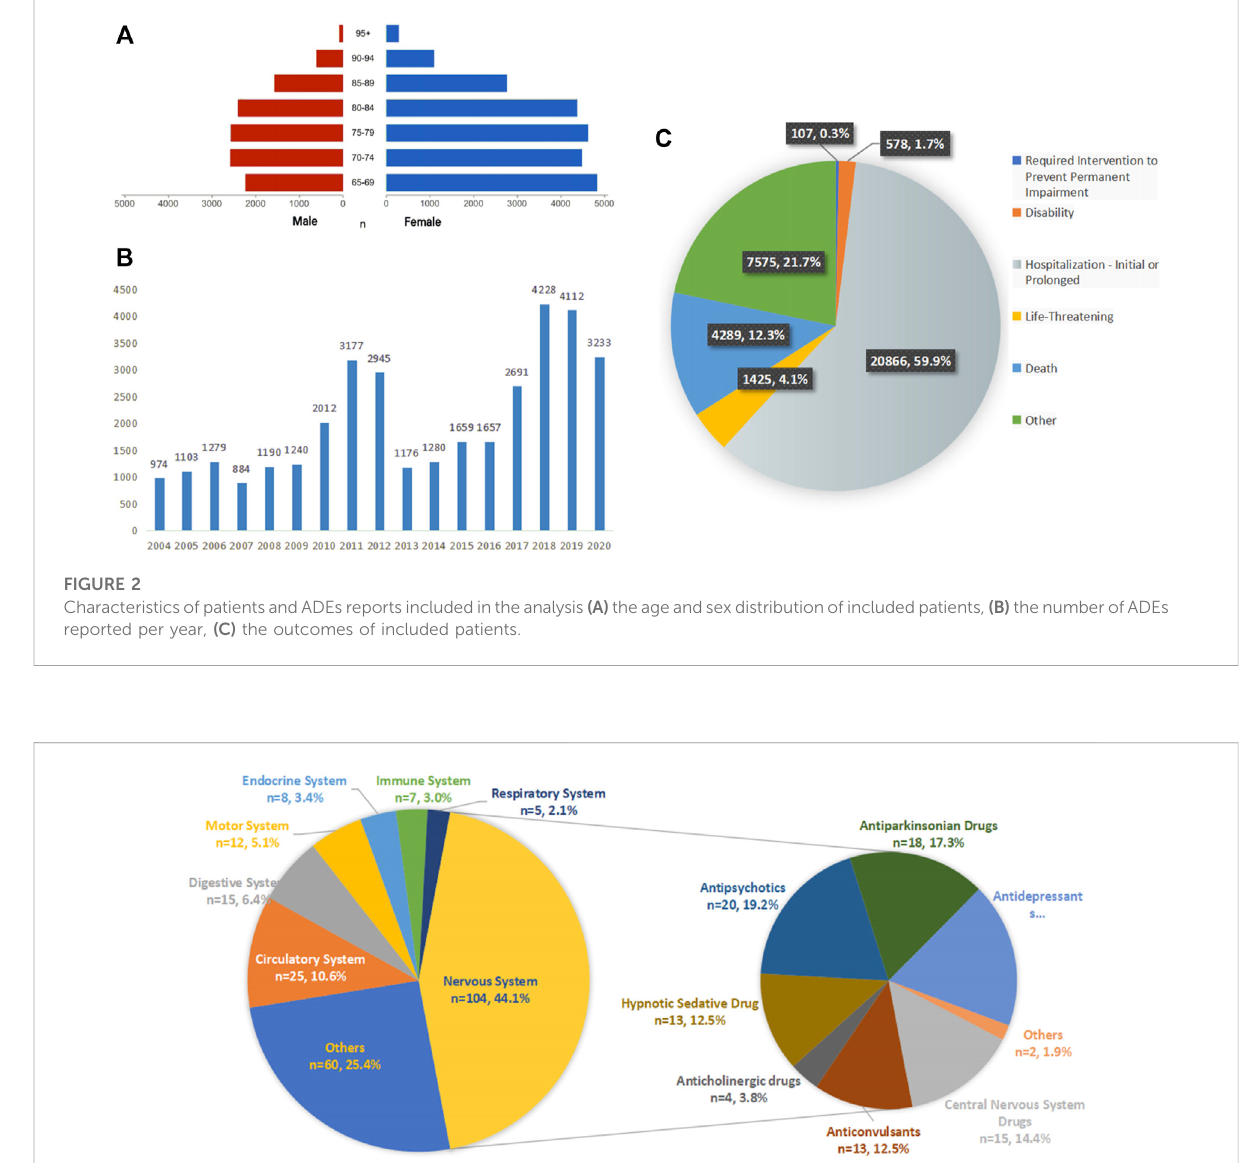
FIGURE 3 The number of drugs with positive signals detected for each physiological